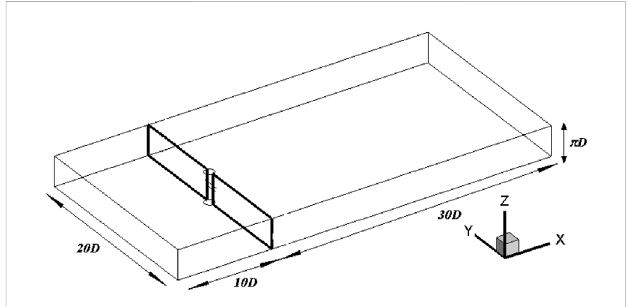
FIGURE 1 Global view of the computational domain for fl ow